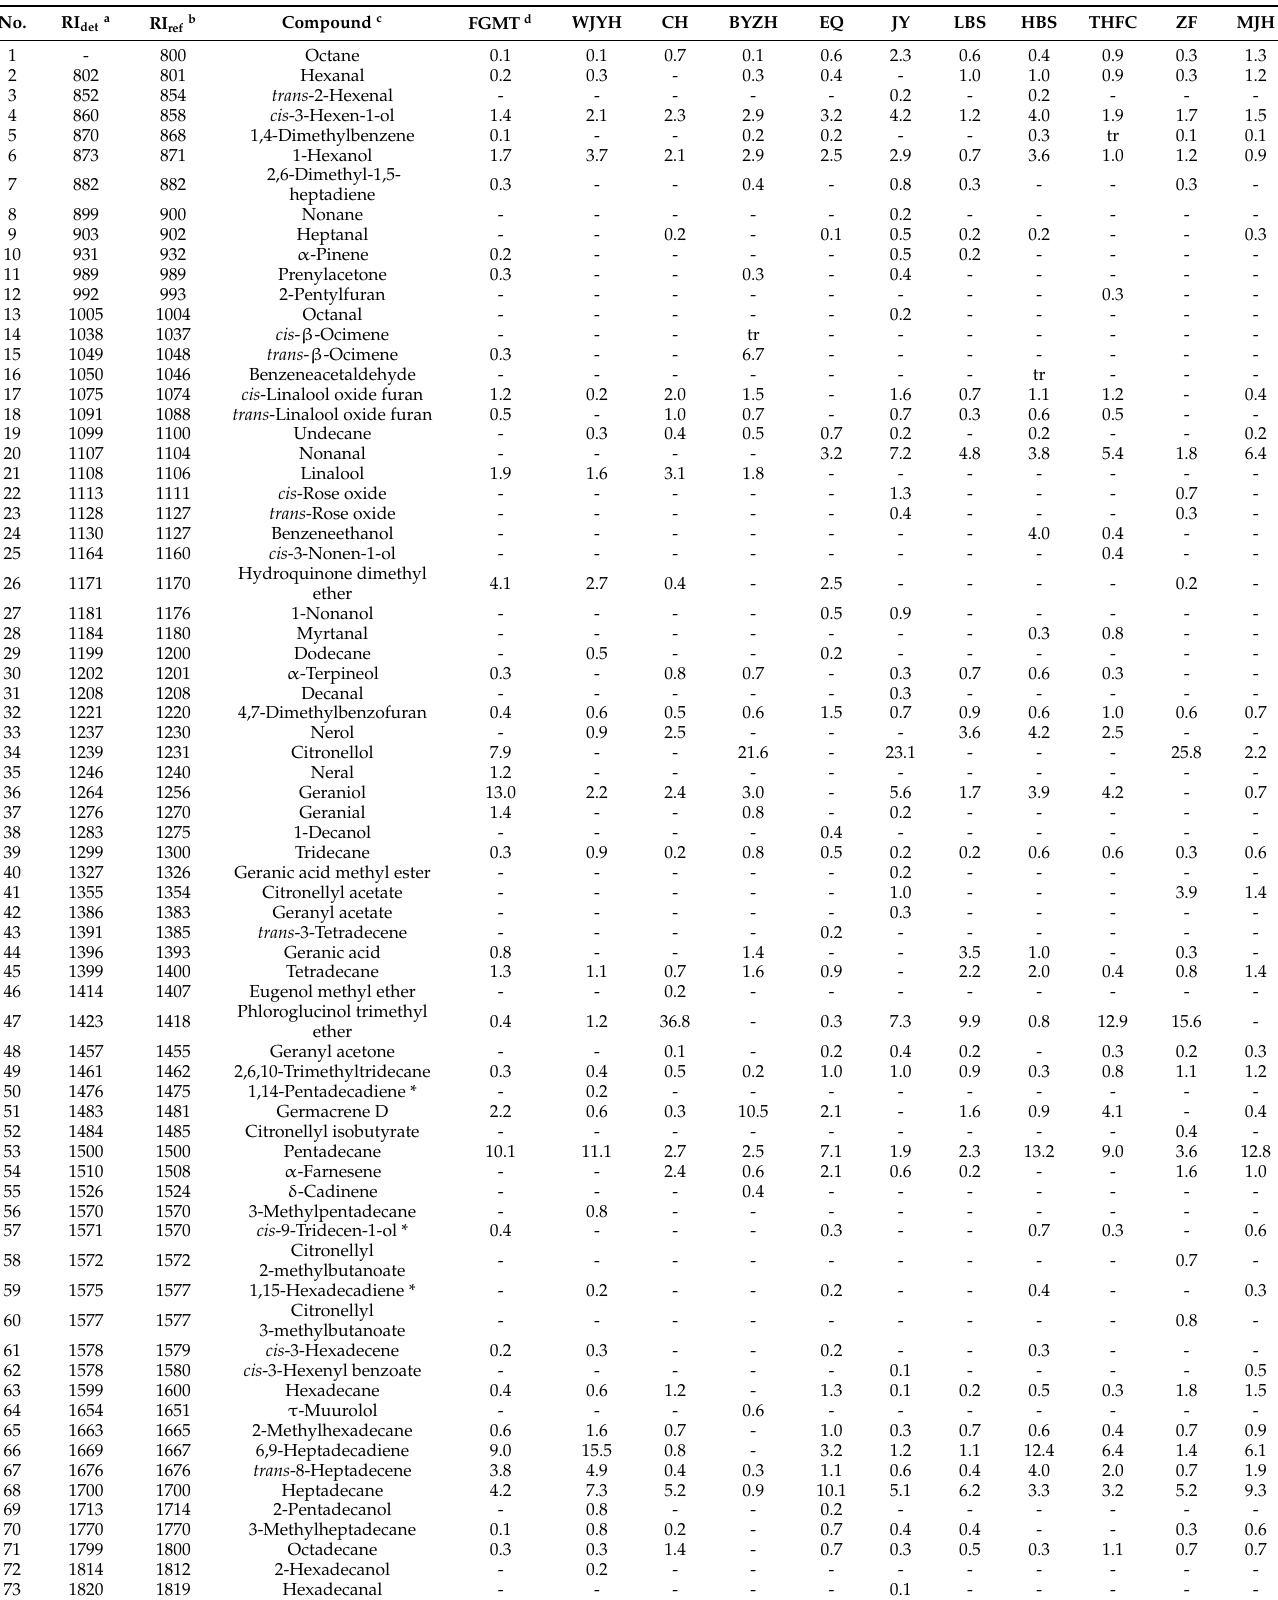
Table 2. Chemical composition of flower essential oils of the eleven woody peony cultivars ( Paeonia × suffruticosa